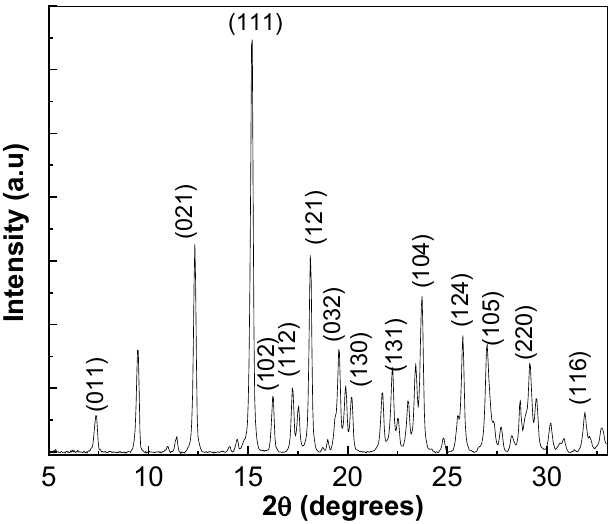
Figure 1. Diffractogram of AM.